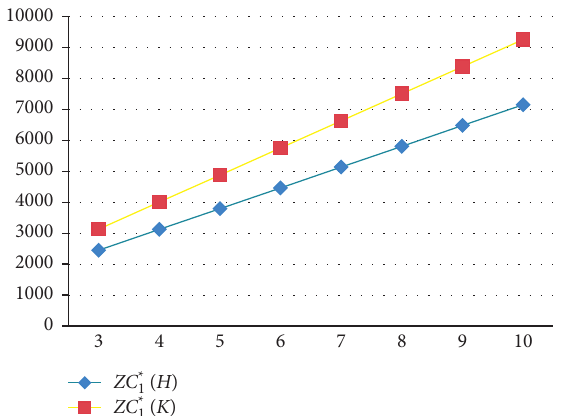
index for H and K networks on 1